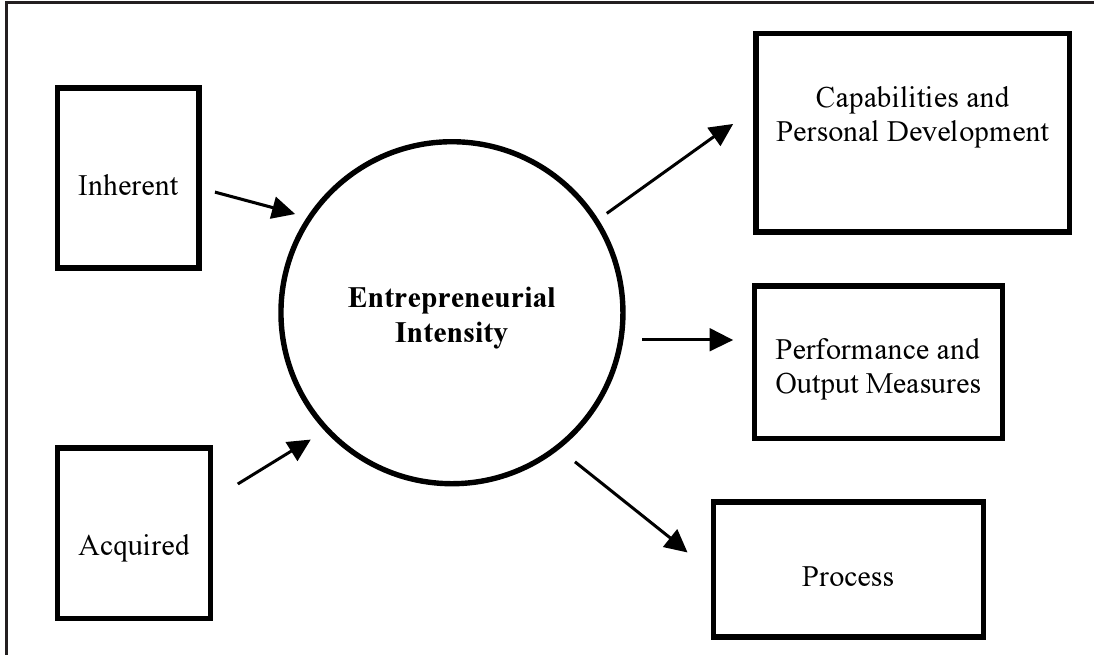
Figure 2. Entrepreneurial Intensity: Antecedents and